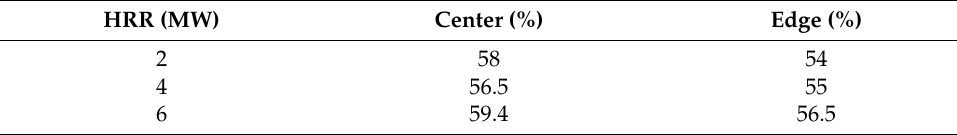
Table 4. Transmittance of water film to incident heat flux.